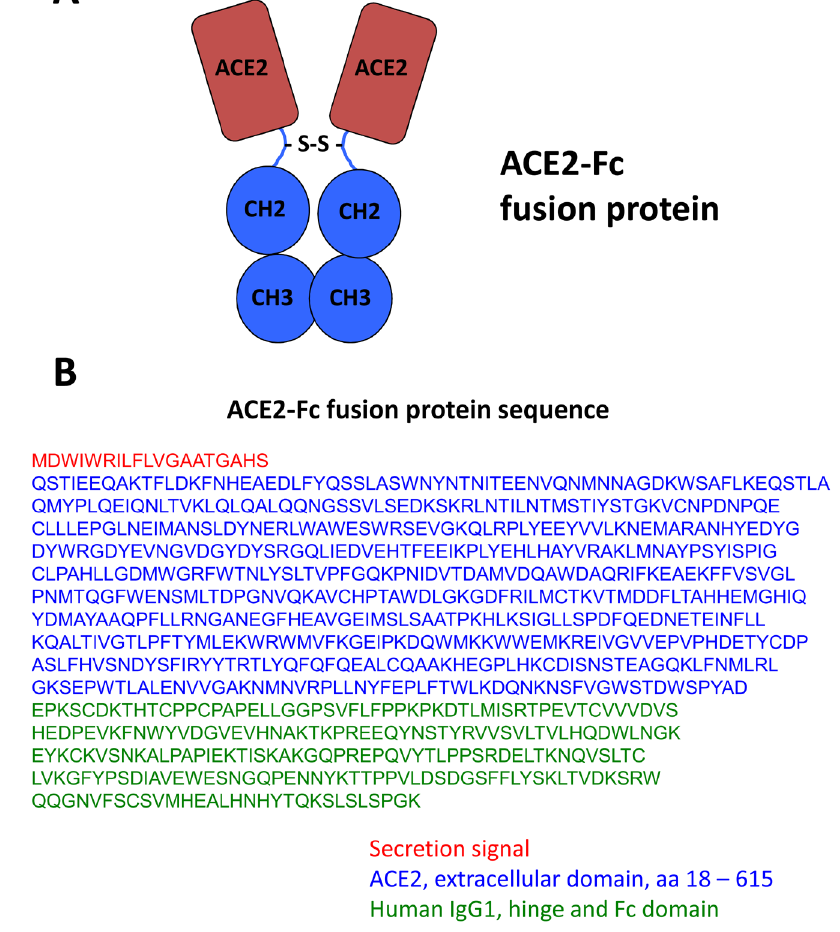
Figure 2. TherapeuticDesign of the ACE2-Fc fusion protein as a therapy against 2019-nCoV coronavirus. ( A ) The extracellular domain of ACE2 is appended onto the human immunoglobulin Fc domain, including the hinge region. The Fc domain facilitates dimerization of two ACE2 domains. ( B ) The amino acid sequence of the ACE2-Fc fusion protein is provided. The ACE2 domain consists of amino acids 18–615 of the human ACE2 protein (blue; UniProtKB - Q9BYF1). The sequence of the human immunoglobulin G isotype 1 constant region is provided (green; UniProtKB - P01857). A secretion signal from a human immunoglobin heavy chain is provided (red; UniProtKB -